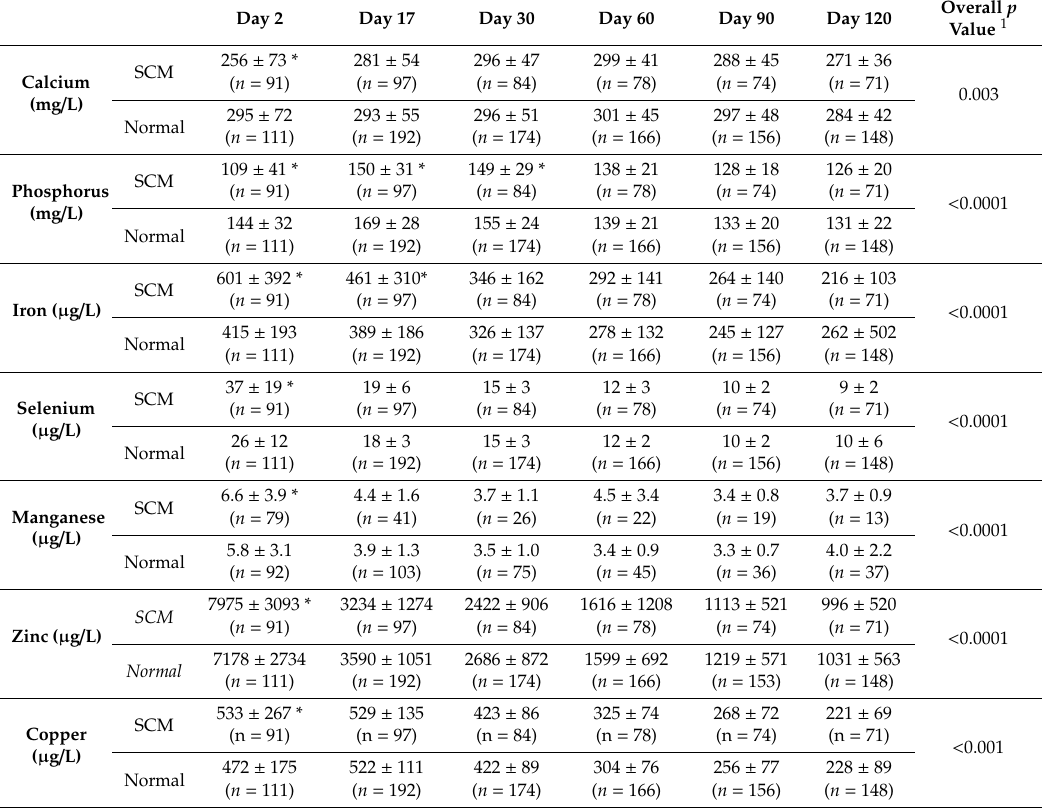
Table 3. Mineral and trace element concentrations of HM across four months of lactation by presence or absence of